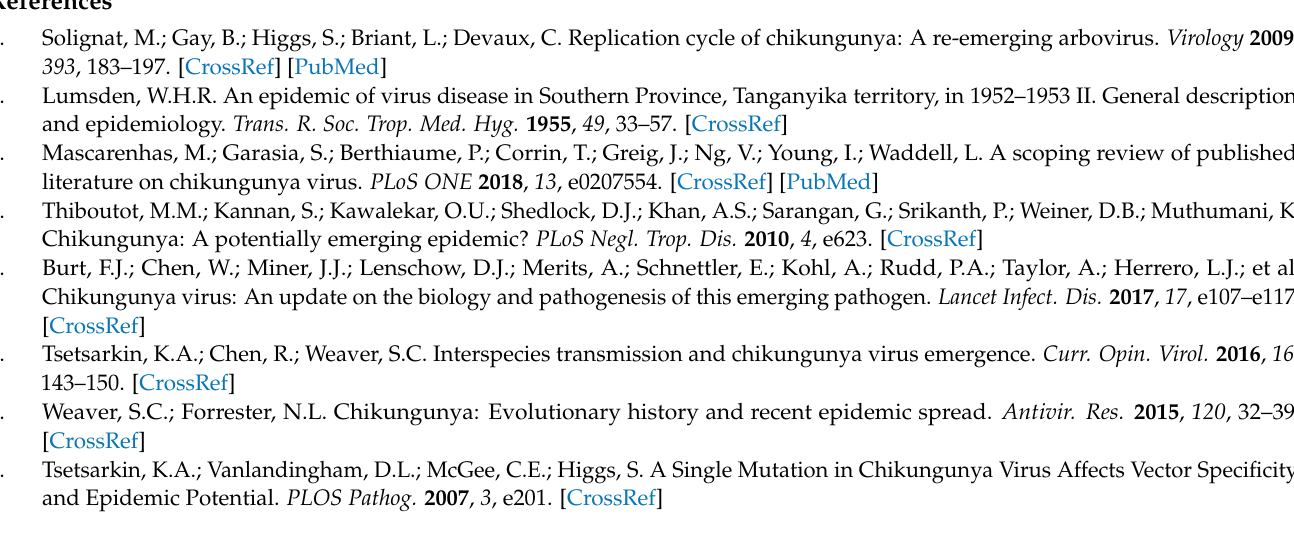
Figure S5: Structure of the Chikungunya Virus (CHIKV) Envelope Proteins, Data S1: contig sequences CHIKV A549